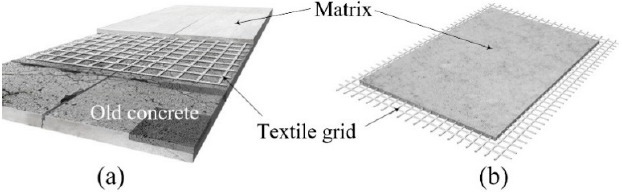
Figure 1. Schematics of TRC system used for: ( a ) repair or strengthening; and ( b ) precast element.